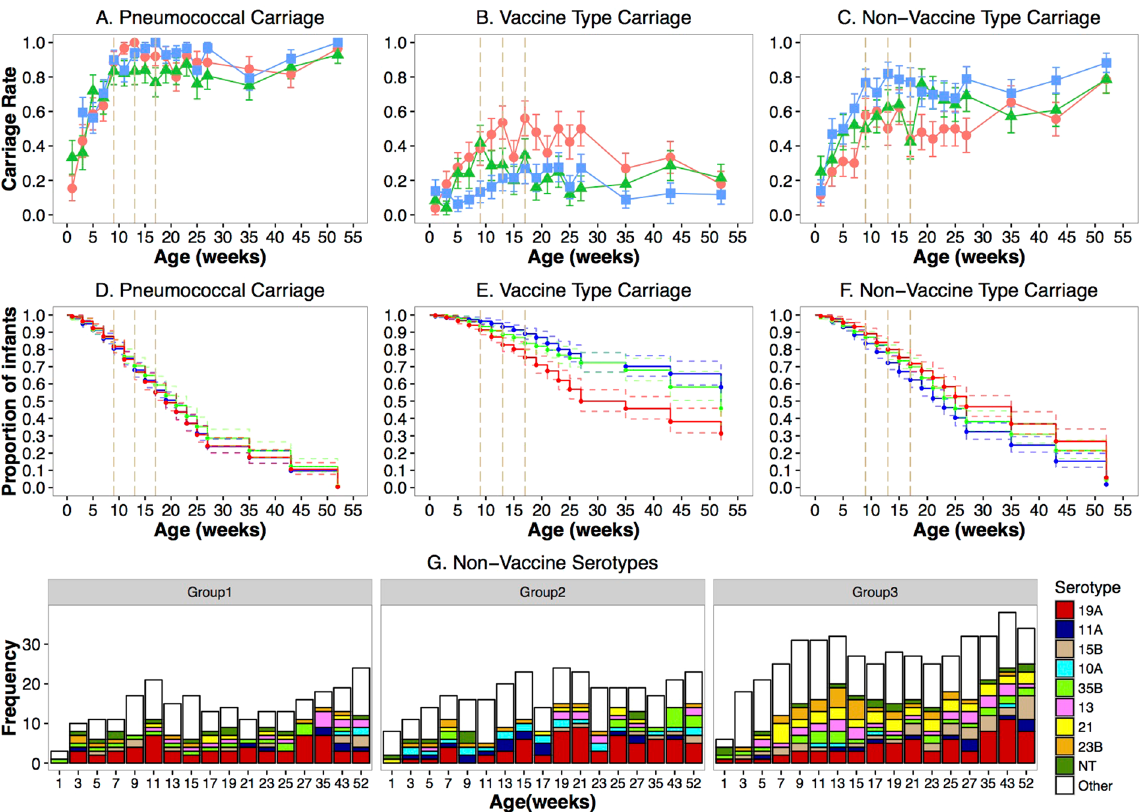
Figure 2. Nasopharyngeal carriage dynamics of pneumococcus, vaccine and non-vaccine serotypes in the first year of life. Carriage rates of pneumococcus ( A ), vaccine ( B ) and non-vaccine serotypes ( C ). Kaplan Meier Survival Curve for time to first acquisition of pneumococcus ( D ), vaccine serotypes ( E ) and non-vaccine serotypes ( F ). Distribution of the top ten vaccine serotypes by group ( G ). The vertical dashed lines are the study 2, 3, and 4 month vaccination time points. P values generated from an adjusted logistic regression model. The line colour denotes the group: red for Group 1, green for group 2 and blue for Group